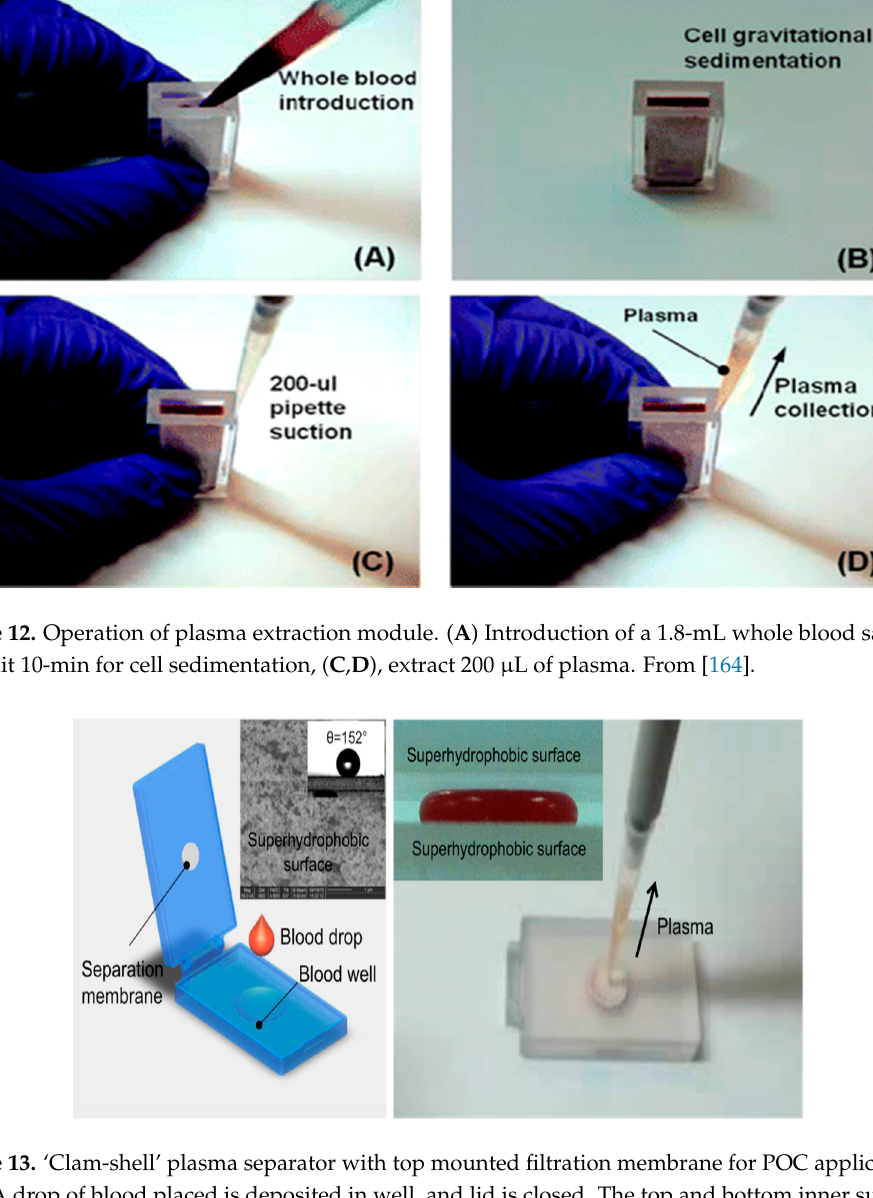
Figure 11. ( A ) Exploded view of pump-free, membrane-based, sedimentation-assisted plasma extraction device. The Vivid ™ polysulfone membrane separates plasma from blood cells, and features pores with large ( ∼ 100 micron) on the whole-blood side that narrow to ~2-micron diameter on the plasma side. ( B ) assembled module. From [163].